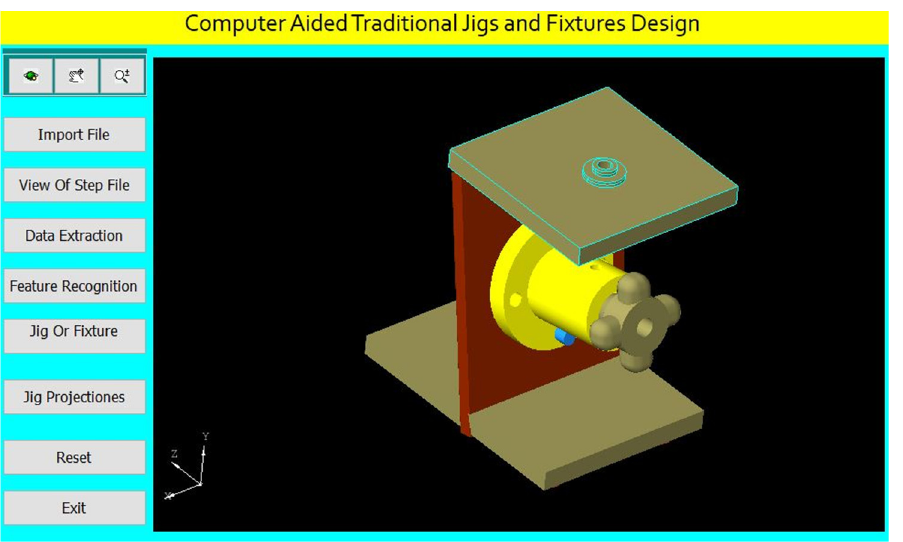
Figure 52. Computer-aided design of a jig for the cylindrical part.